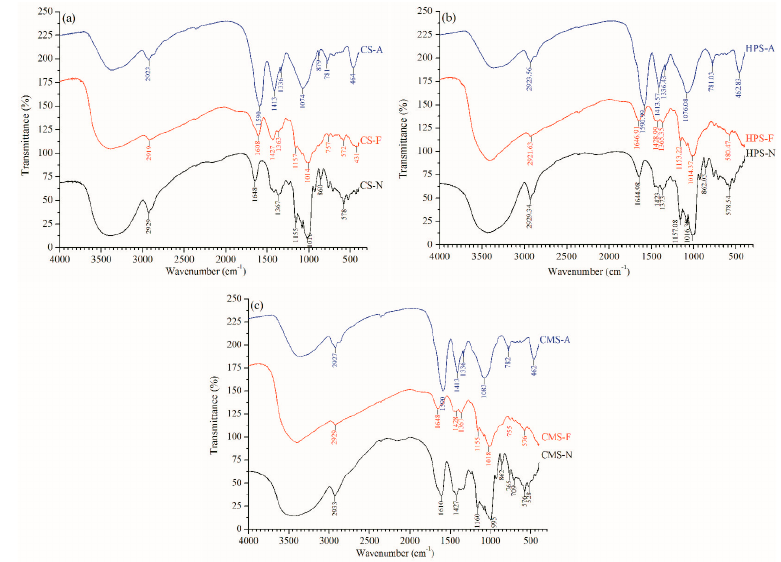
Figure 9. The FTIR spectra of non-treated starches (N), the filtrate-treated starches before (F) and after (A) heated at 200 °C for 5 h: ( a ) CS; ( b ) HPS; ( c ) CMS. (A) heated at 200 ◦ C for 5 h: ( a ) CS; ( b ) HPS; ( c )